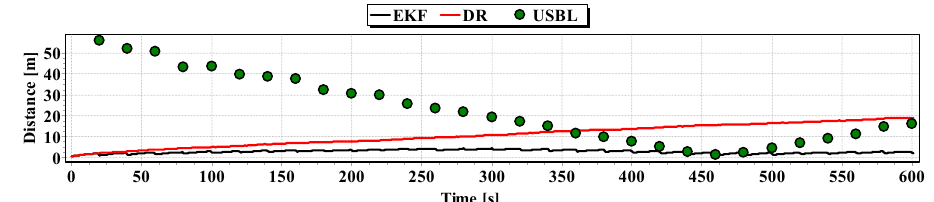
Figure 24. Determined route (one hundred passages).